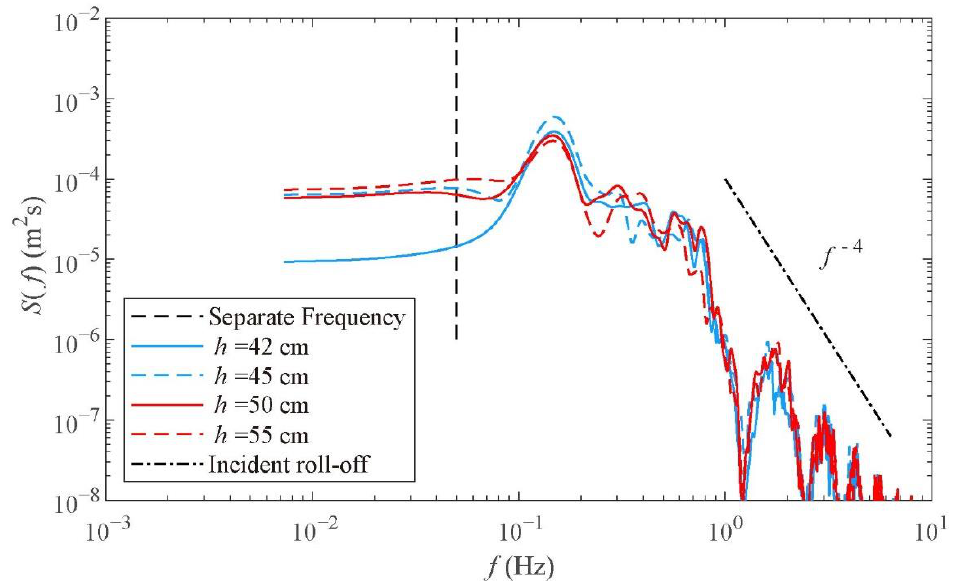
Figure 7. Swash spectrum evolution with the same wave condition and different experimental water depths on the plane beach (T00, T01, T06, T11). The black dash line is the separation frequency of the incident swash band and infragravity swash band.